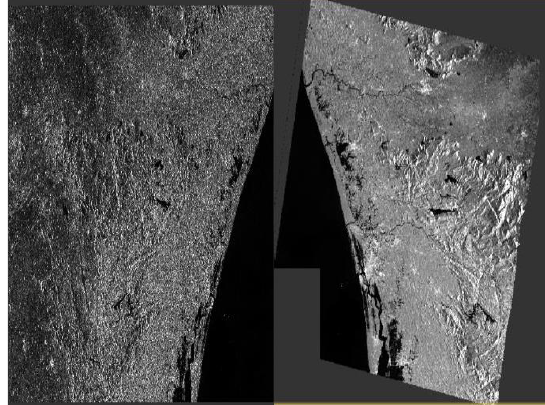
Figure 3. Pre-Processing before & after, first image is a raw data and the second one is Pre-processing image Figure 5. Pre & Post Event of Flood in 2019 The delineation of water pixels to identify the total flood inundated area and masked the permanent water body to differentiate the changes over a study area. The NDWI was processed to find the permanent water body shows in Fig(6) here the PWB were extracted to estimate inundated area of pre-existing features, the black colour depicts the land cover and the white colour as a water body. Figure (6) Shows a permanent water body in 2018 and 2019.